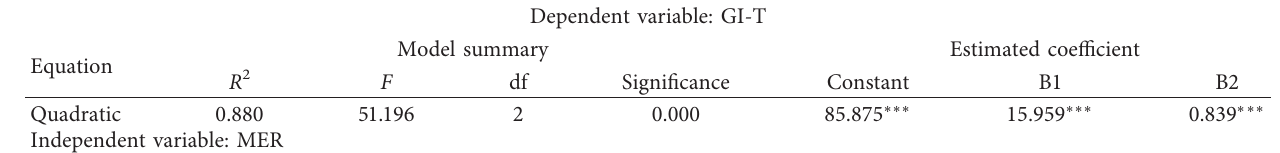
Table 7: Results of evolution relationship analysis on MER and GI-T.